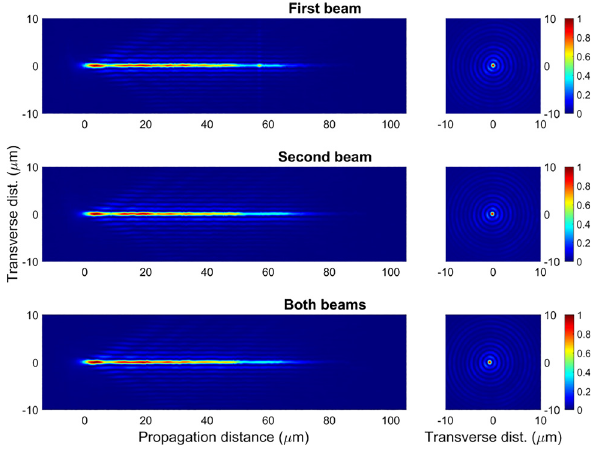
Figure 2: (Left column): Experimental longitudinal intensity distribution for single and double pulses. (Right column): Correspondingexperimentalintensitycrosssections.Allimagesare normalized to their own